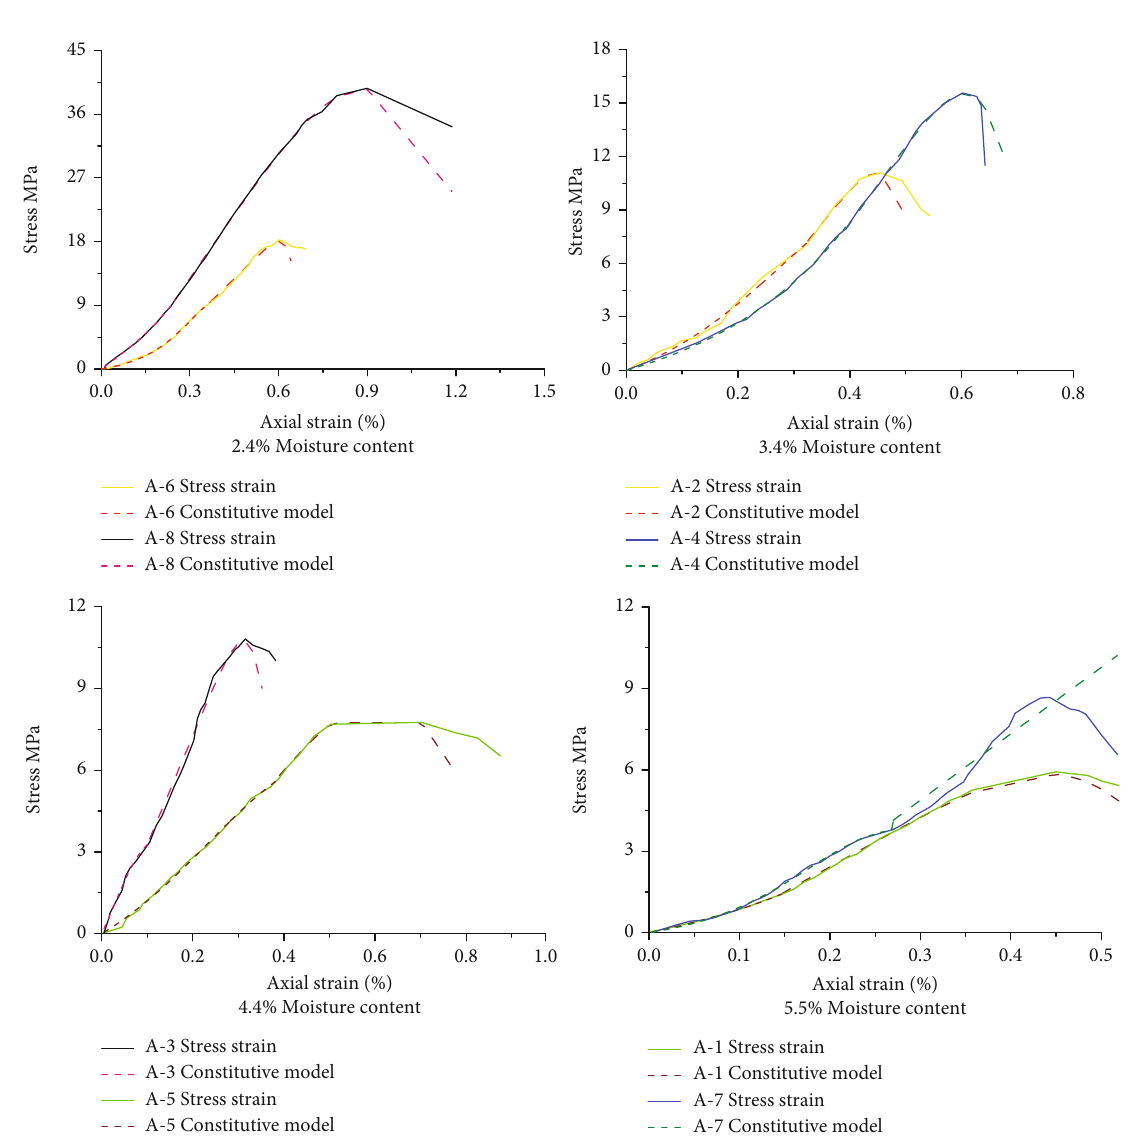
Figure 15: Constitutive model diagram of di ff erent water